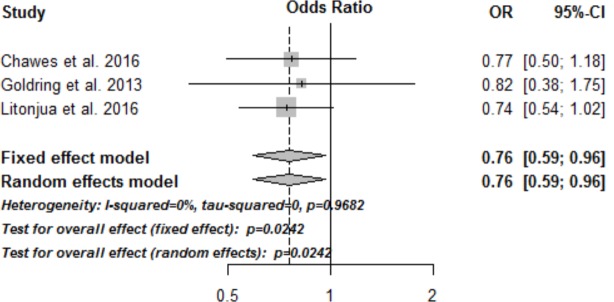
Forest plots of the meta-analysis of asthma/recurrent wheeze in all three published randomized trials of vitamin D intervention in pregnancy and subsequent asthma/recurrent wheeze at age 3 years.